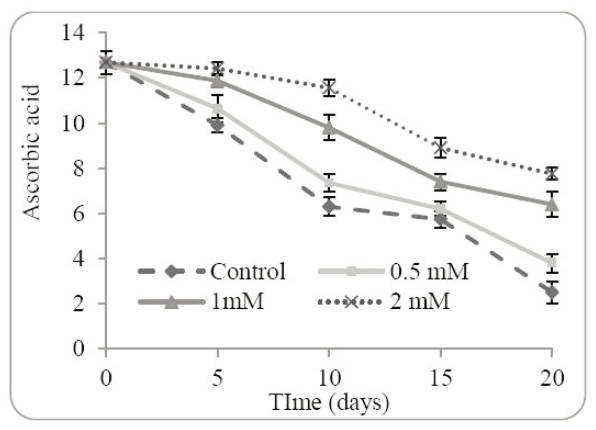
Fig. 4 - The effect of putrescine at different concentrations (0.5, 1 and 2 mM) on ascorbic acid of Musa acuminata L. dur- ing storage.